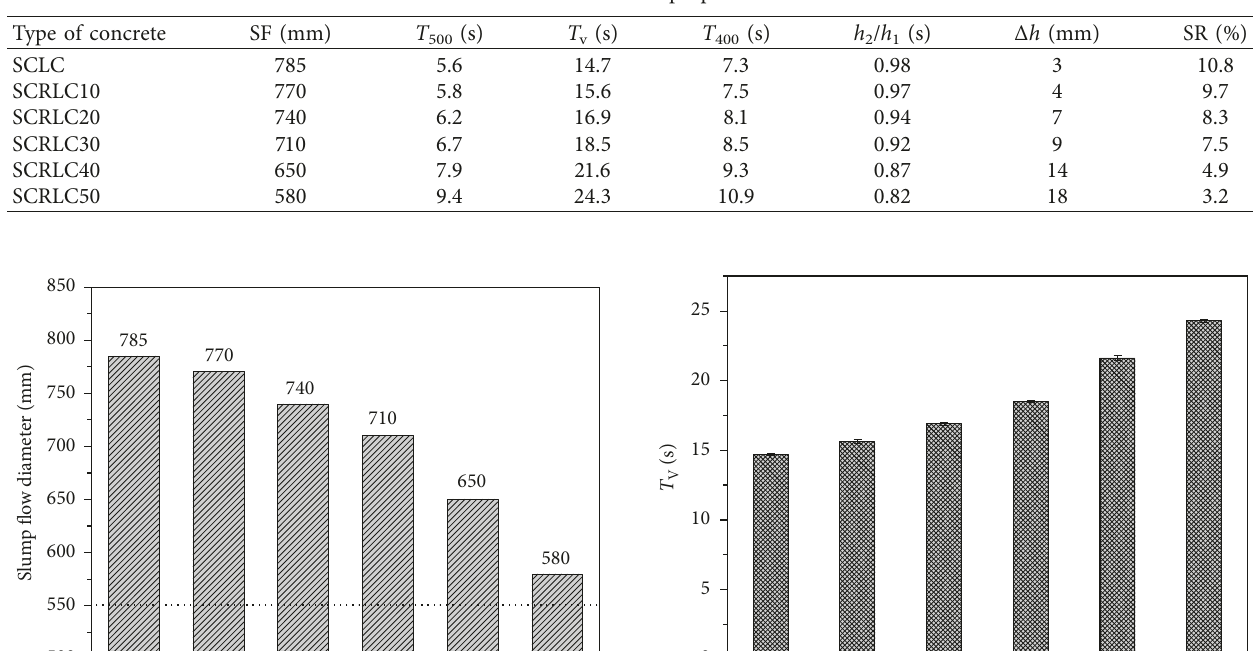
Table 4: Test results of fresh properties of SCRLC.